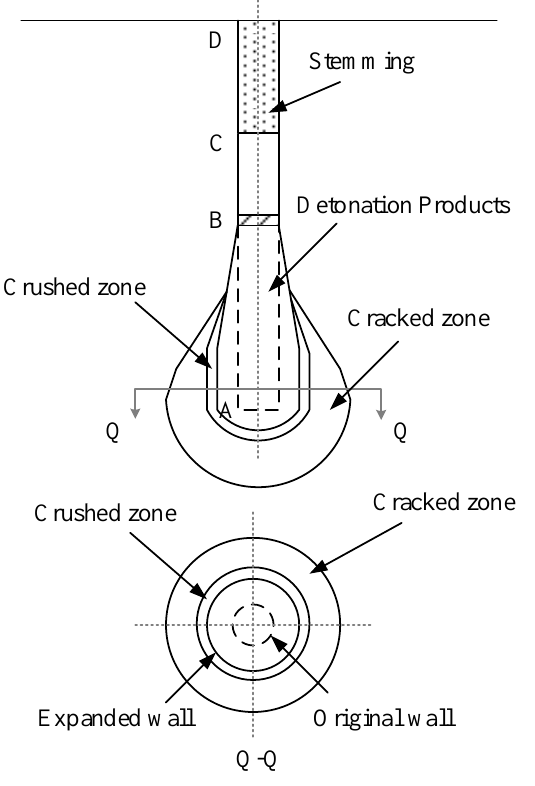
Figure 1. The blast hole and surrounding damages.